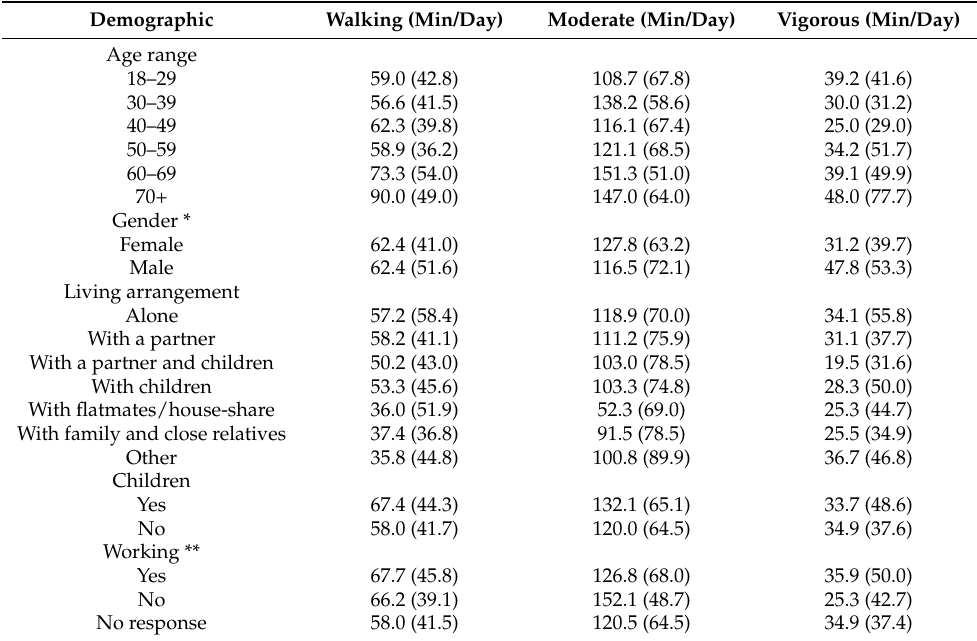
Table 2. Self-reported physical activity.